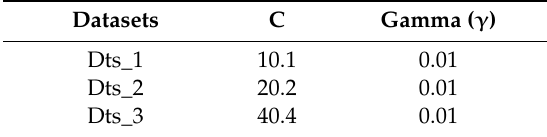
Table 10. Optimized C and Gamma parameters for the radial basis function (RBF)-kernel.